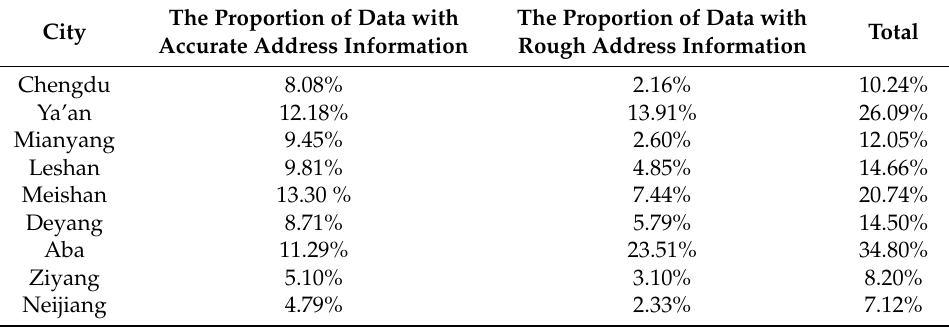
Table 3. Proportion of data with different accuracy in different cities.